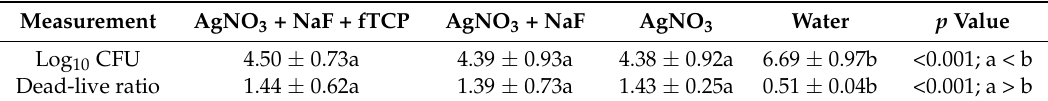
Table 1. Growth kinetics (log 10 CFUs) and viability (dead-live ratio) of S. mutans in the biofilm of the four treatment groups after seven days.